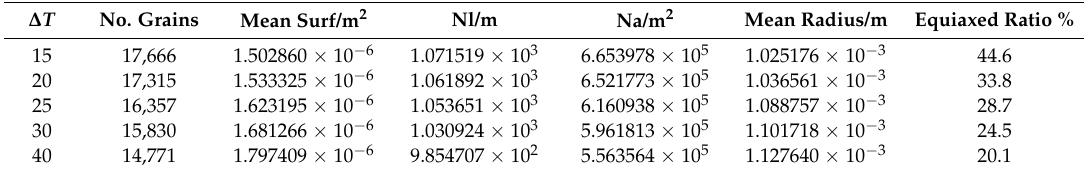
Table 6. Statistic of grain parameters in the bloom under different superheat (1/4